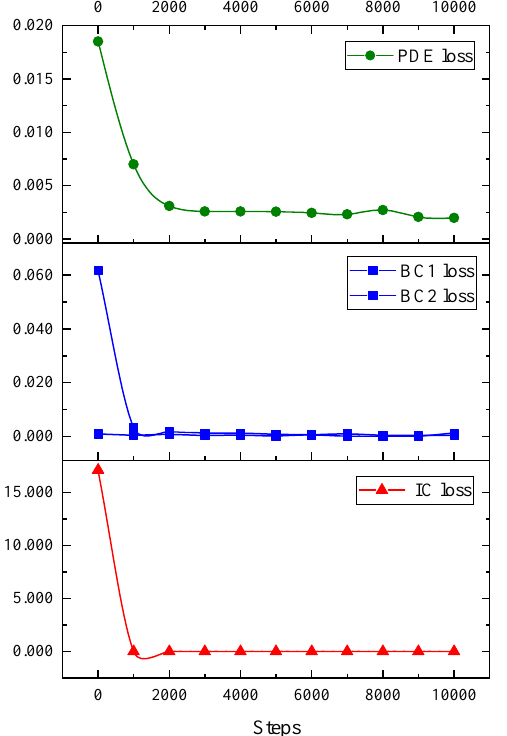
Figure 8. Testing results for two-dimensional consolidation model of drainage at a top